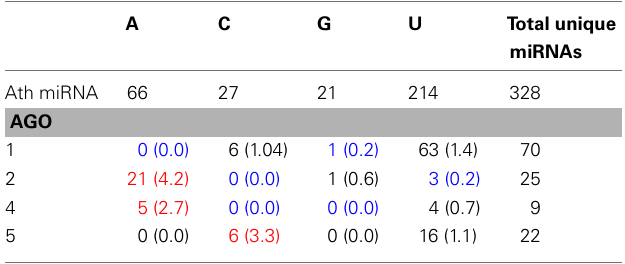
Table 1 | Base composition of the 5 (cid:48) -positions of all Arabidopsis thaliana (Ath) miRNAs as contained in miRBase and for sequence-unique miRNA found to be specifically associated with AGO proteins 1, 2, 4, and 5,